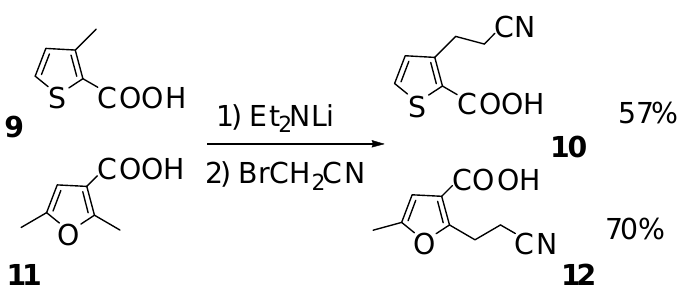
Scheme 2 : Reaction of bromoacetonitrile with o -methyl aromatic